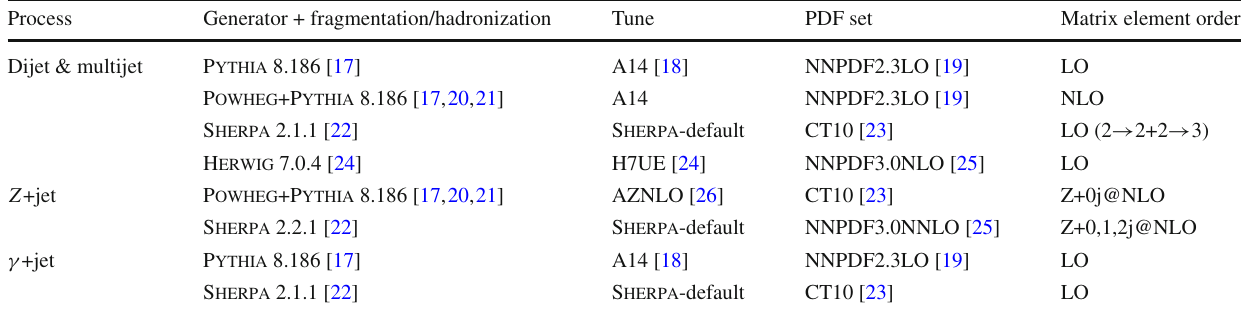
Table 1 List of generators used for various processes. Information is given regarding the underlying-event tunes, the PDF parameter sets, and the perturbative QCD highest-order accuracy used in the matrix